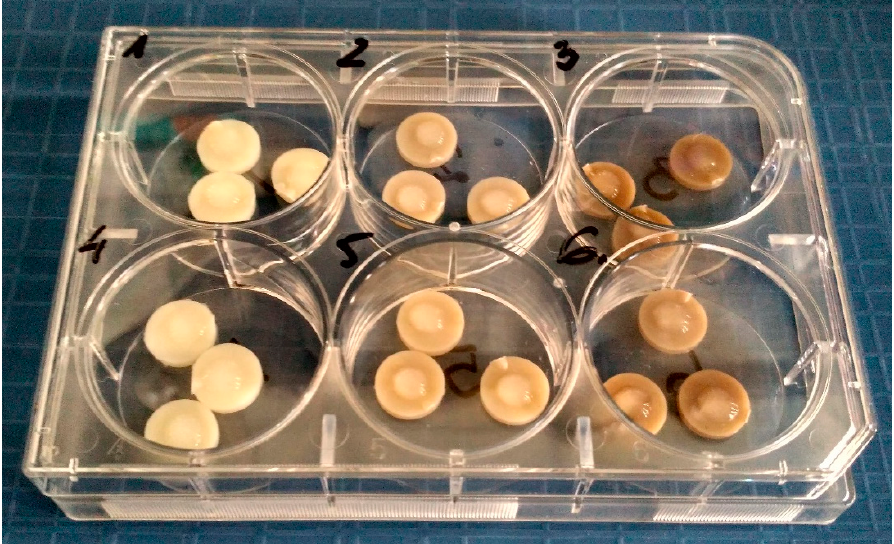
Figure 8. Exemplary 6-well plate with discs (control—well 1 and 4; AgNPs 45T 0.1%—well 2 and 5; AgNPs 45T 0.4%—well 3 and 6) topped with the bacteria/soft-top agar suspension.